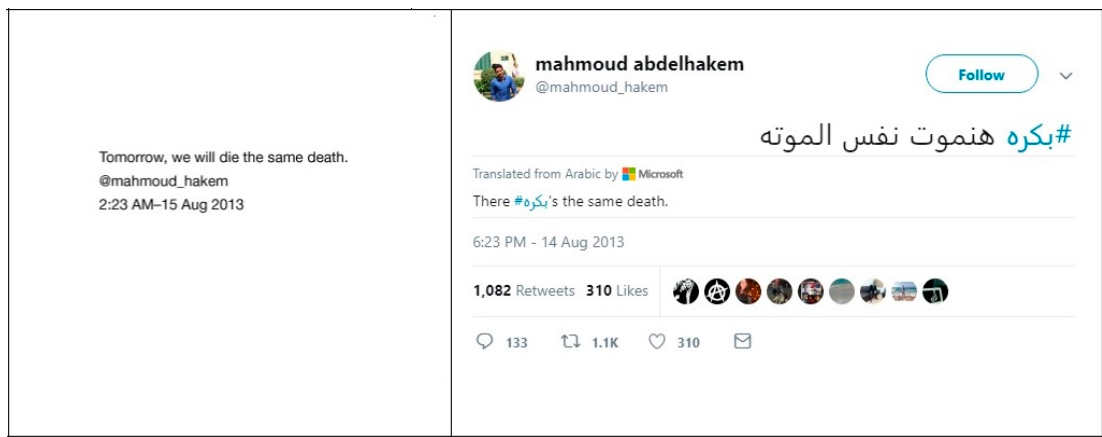
Figure 3. ( Left ) p. 209 of The City Always Wins ; ( Right ) Mahmoud Abdelhakem tweet about dying ‘the same death’ at the Rabaa massacre. The Arabic hashtag, left untranslated by Microsoft Translate, means #tomorrow. 14 August 2013.